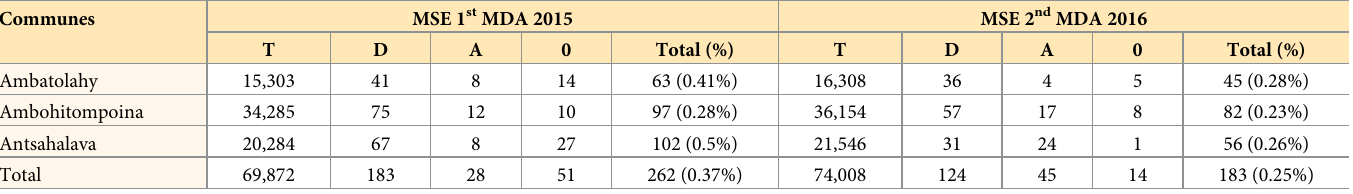
Table 2. Minor side effects (MSE) recorded during a 3-year MDA pilot project for taeniasis control in Madagascar using praziquantel 10mg/kg in patients > 5 years of age. Communes